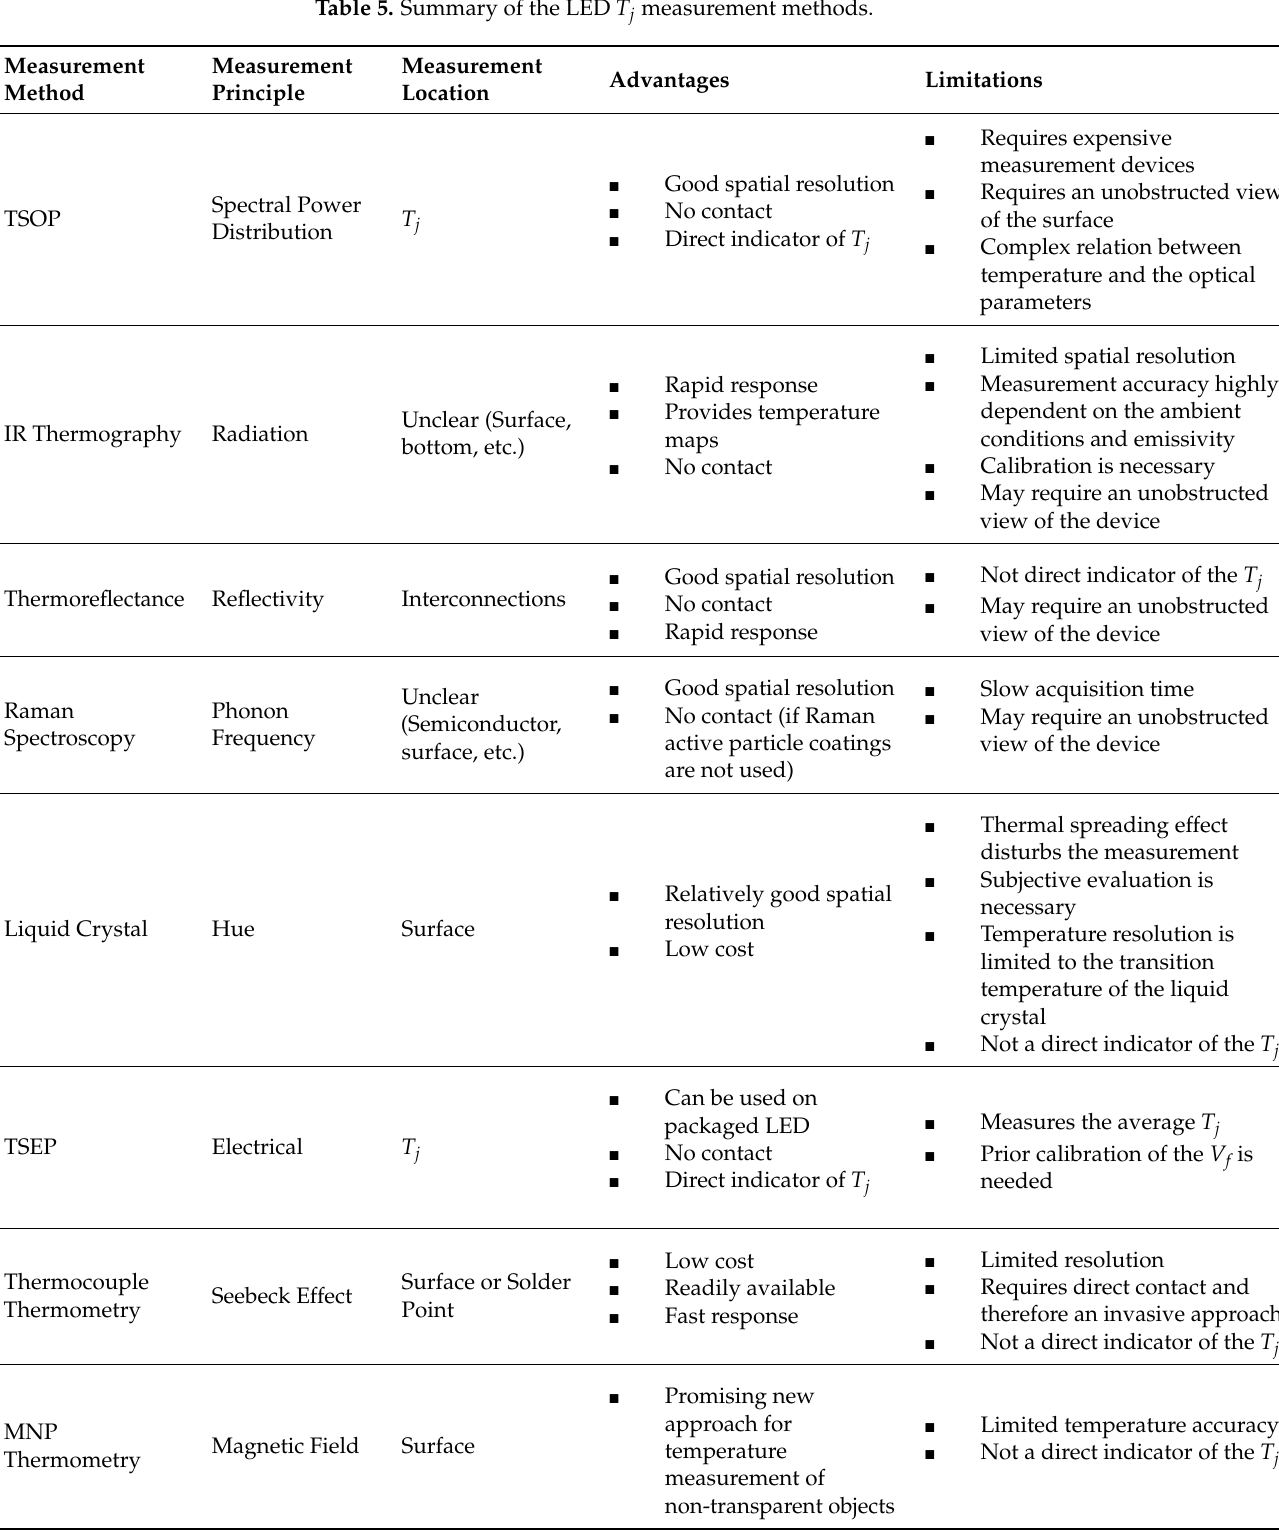
Table 5. Summary of the LED T j measurement